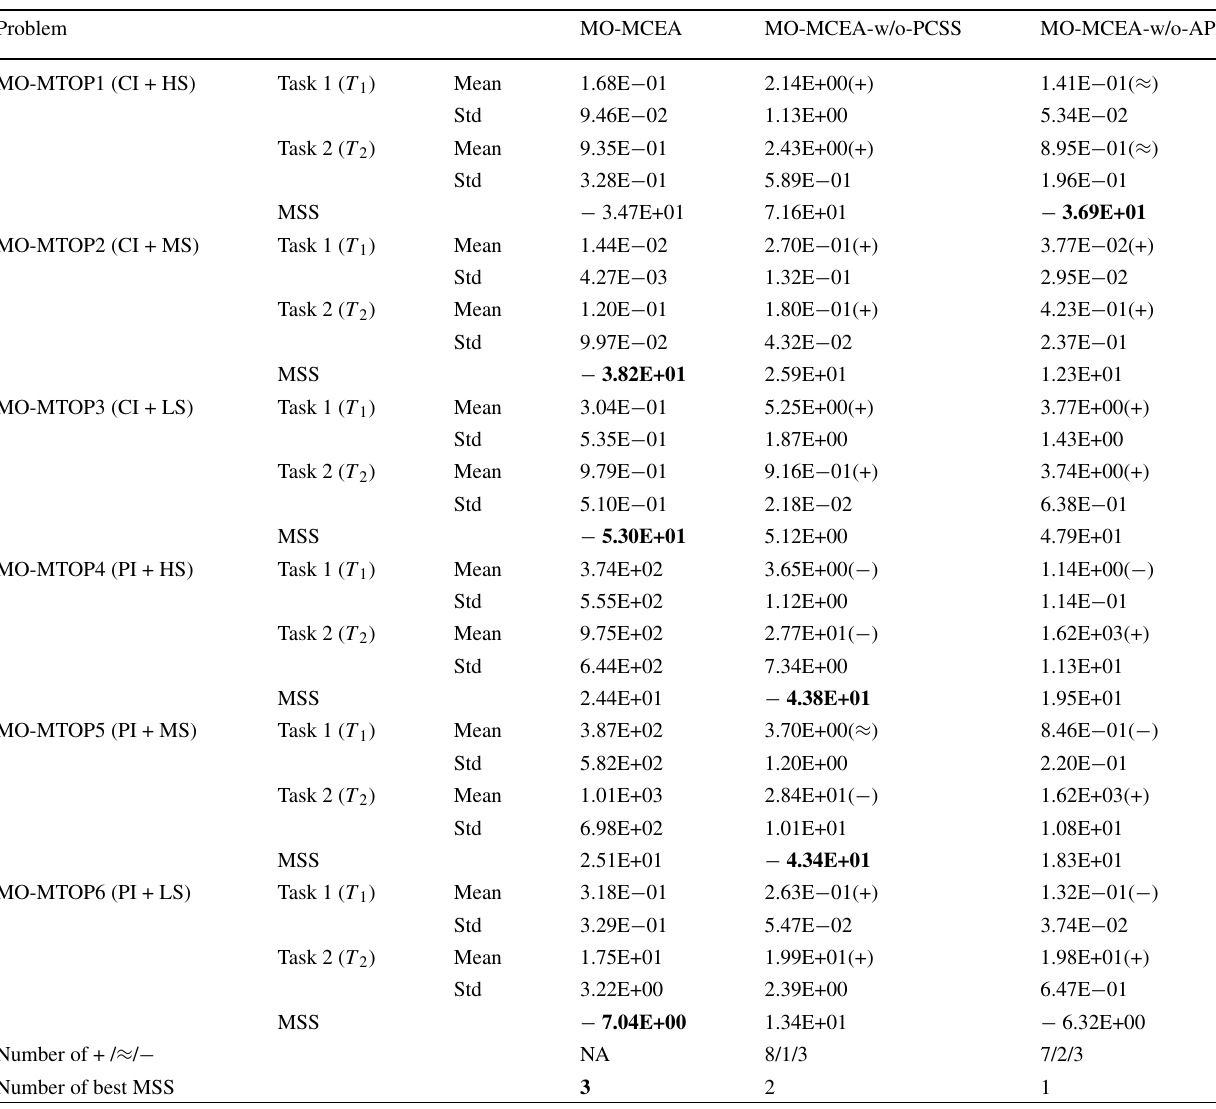
Table 3 Comparisons among the MO-MCEA variants with or without PCSS and APL